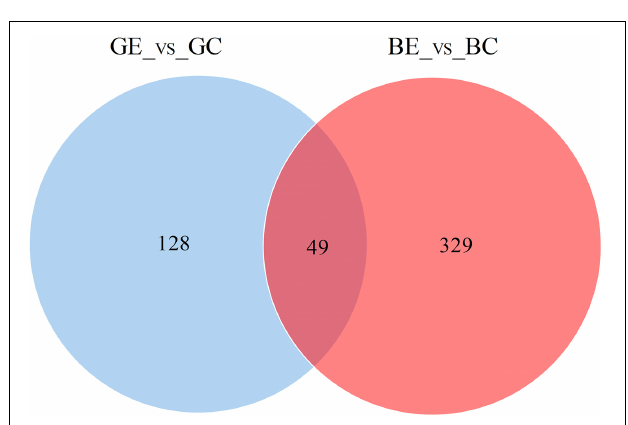
FIGURE 5 | Venn diagrams showing the differentially expressed protein number allocation among the high-efficiency nitrogen-fixing variety B8 and low-efficiency nitrogen-fixing variety GT11 of sugarcane after the inoculation of E. roggenkampii ED5 as compared to